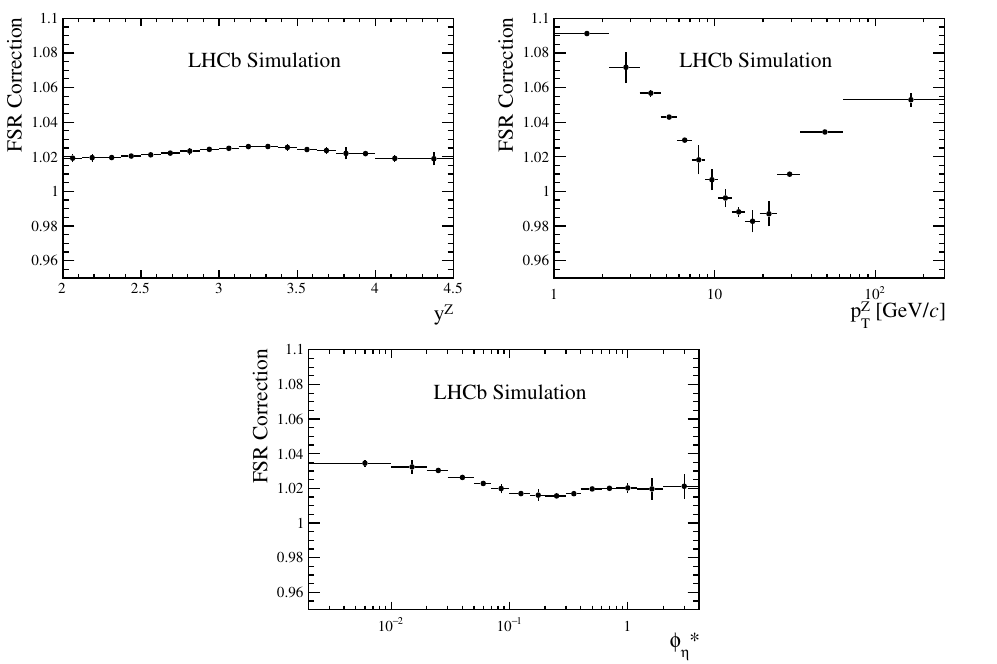
Figure 2 . Final state radiation correction estimated for the (top-left) y Z , (top-right) p Z (bottom) φ ∗ differential cross-section measurements. The error bars represent the total (statistical η and systematic)